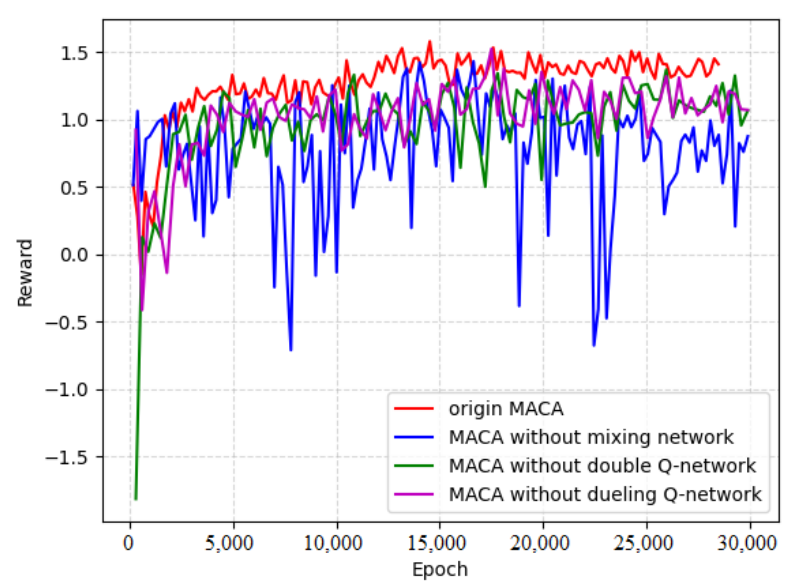
Figure 9. Ablation experiment